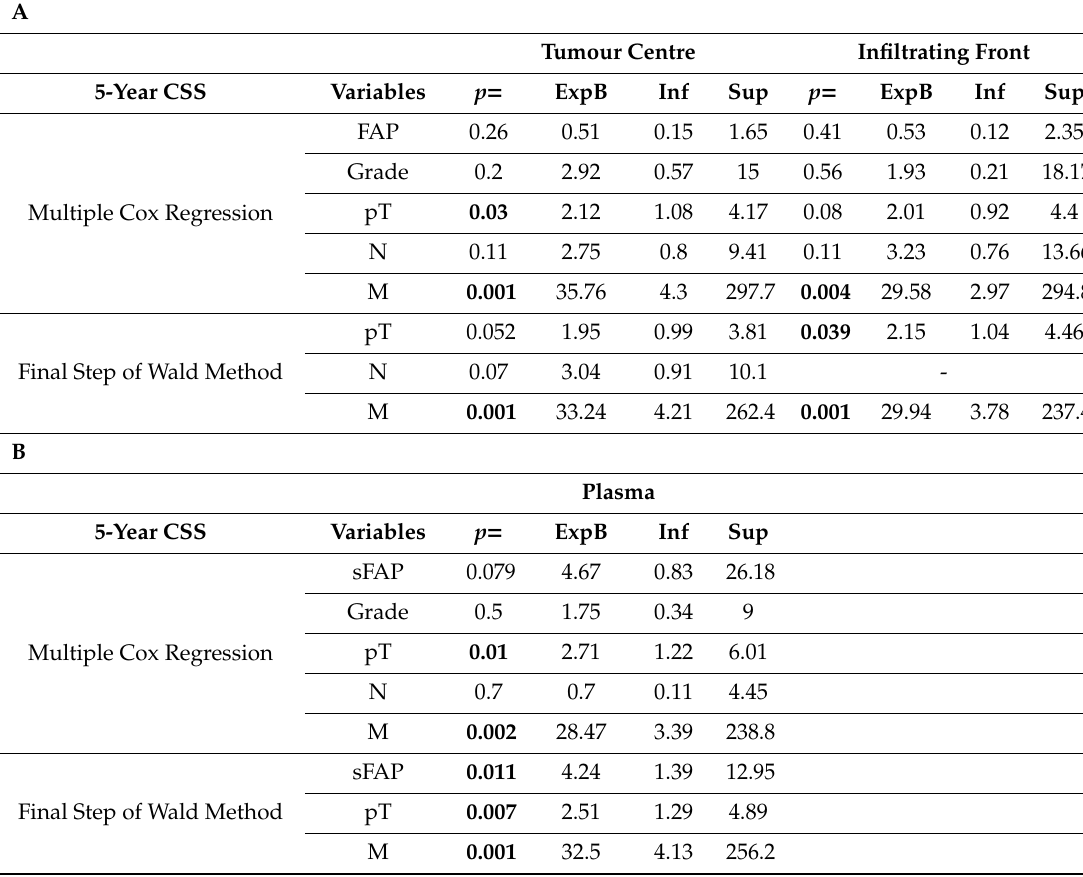
Table 2. Predictive model (Cox regression) for 5-year cancer-specific survival (CSS) prediction in CCRCC patients. Selected independent variables were FAP expression in the primary tumour’s centre and infiltrating front ( A ); plasma sFAP ( ≤ or > 61.03 ng / mL) ( B ); combination of FAP expression in tumour and plasma sFAP (FAP +/ sFAP ≤ 61.03 ng / mL vs. rest of combinations) ( C ); and pathological variables such as Fuhrman grade, local invasion (pT), lymph node (N), and distant (M) metastases. ExpB with confidence interval (CI, inferior and superior) is also included. Statistically significant values are highlighted in